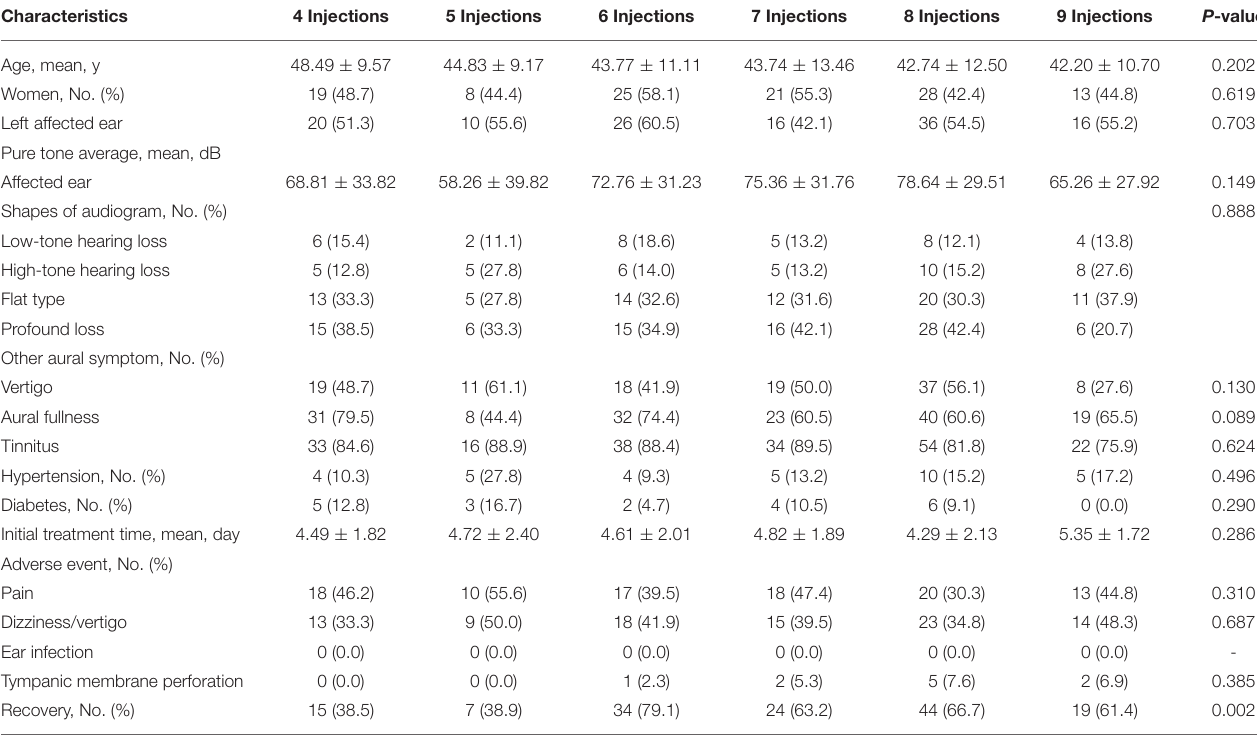
TABLE 4 | Comparision of baseline. Hearing and prognosis characteristics in SSNHL patients according to IT injection number.